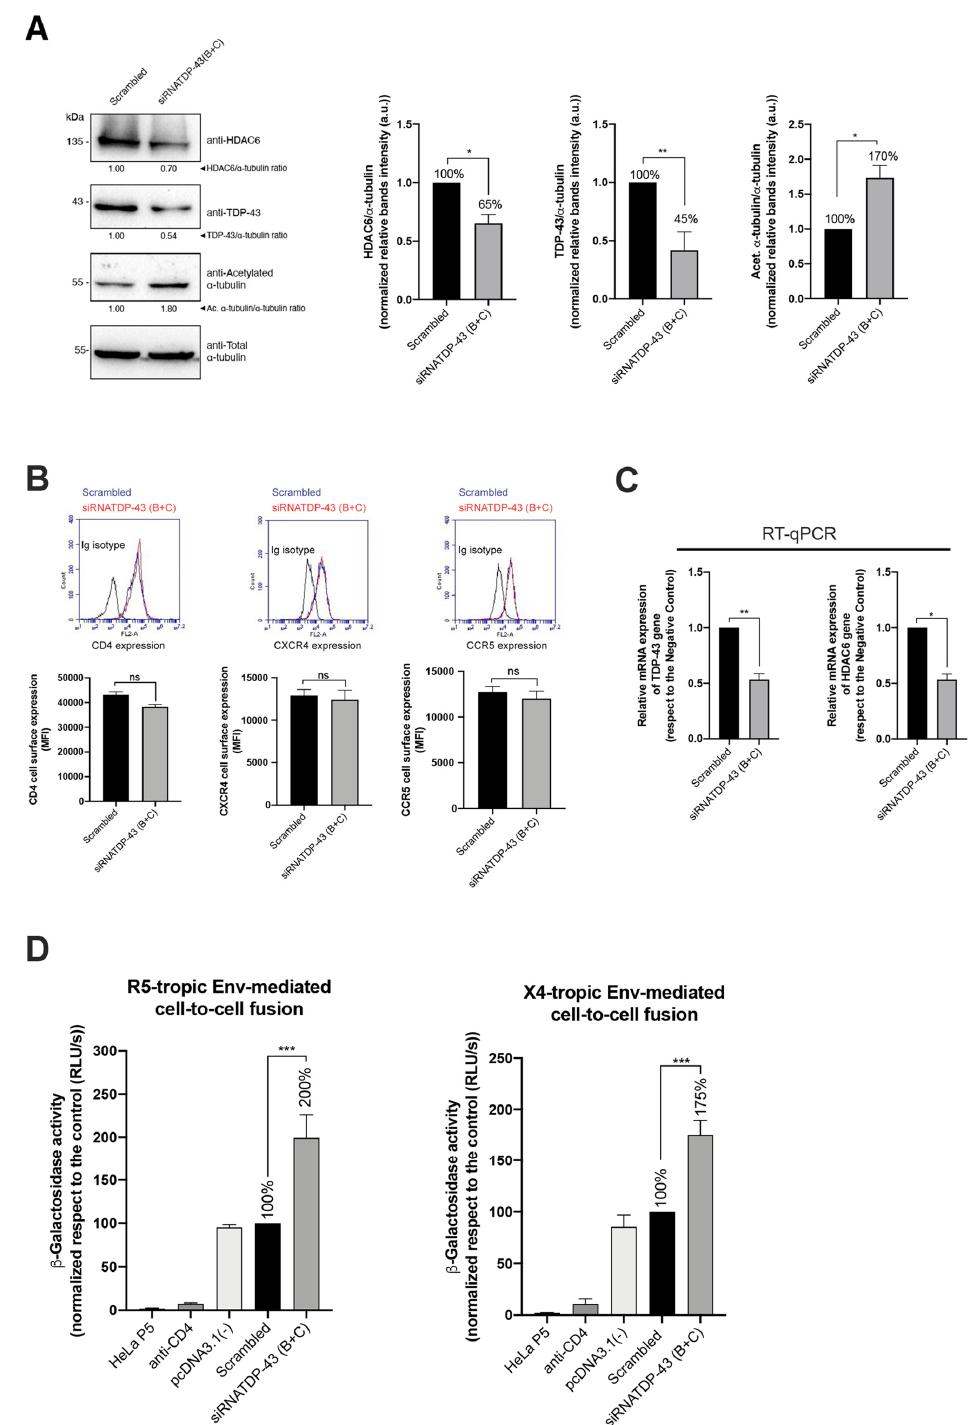
Figure 6. HIV-1 Env fusogenic activity is favored by the interference of the TDP-43 mRNA. ( A ) Left, quantitative Western-blot analysis of endogenous TDP-43, HDAC6 and acetylated α -tubulin